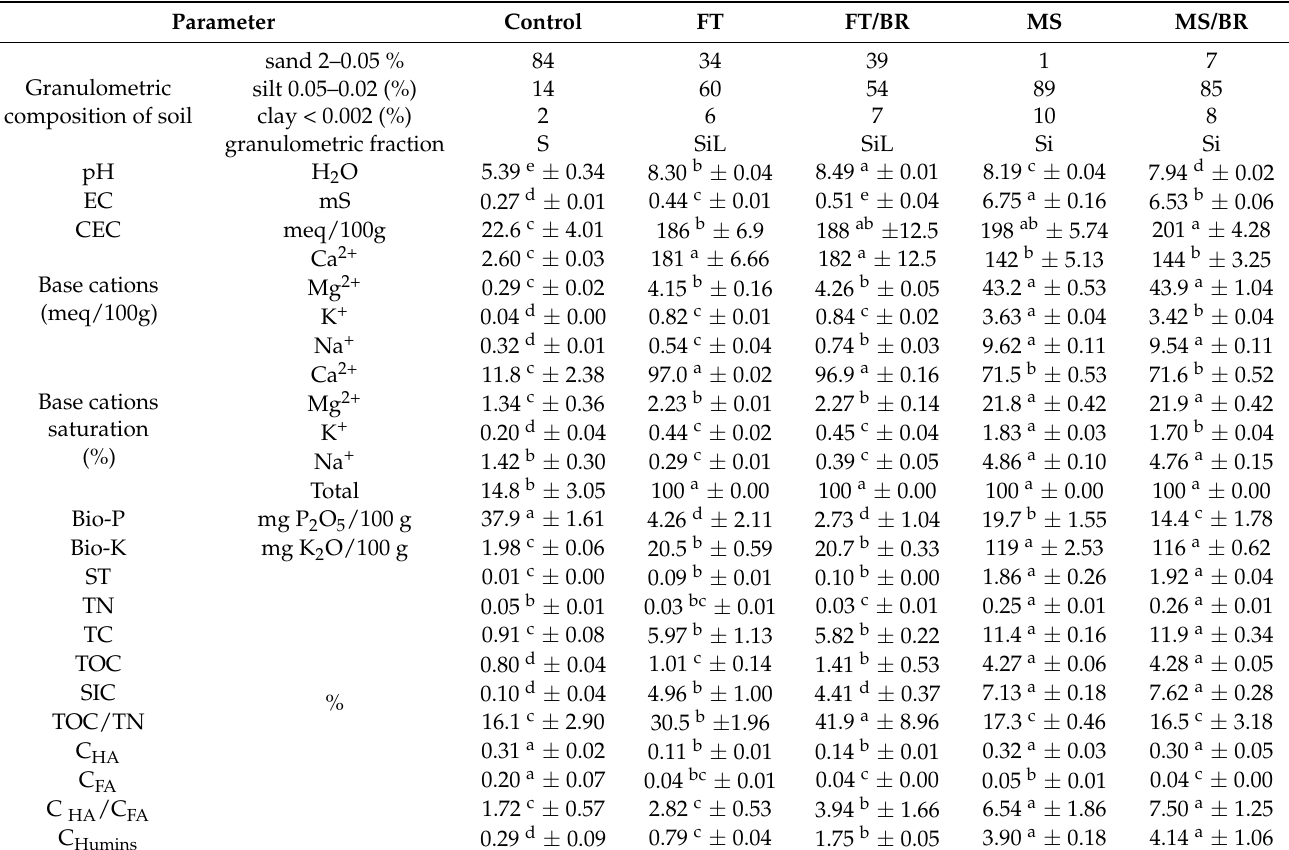
Table 1. Characteristics of experimental